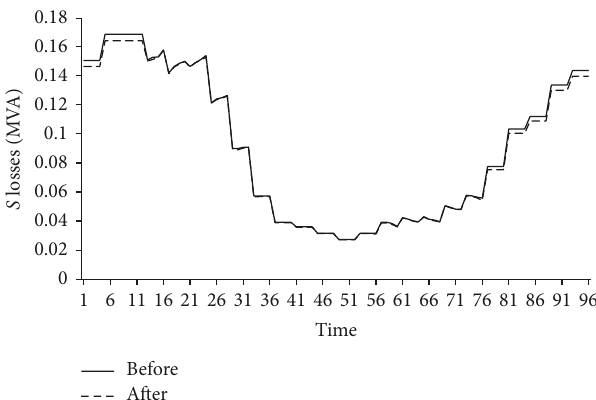
Figure 15: THD 𝑖 summation for 24 hours with and without passive filter.